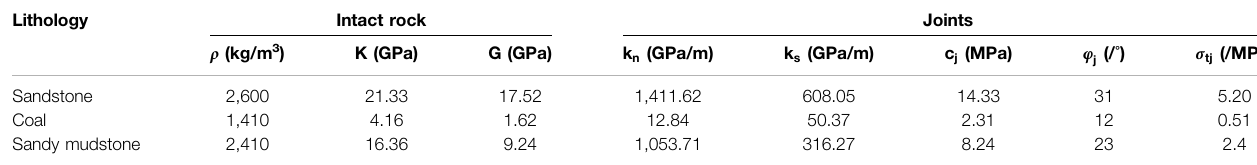
TABLE 1 | Parameters of UDEC model.